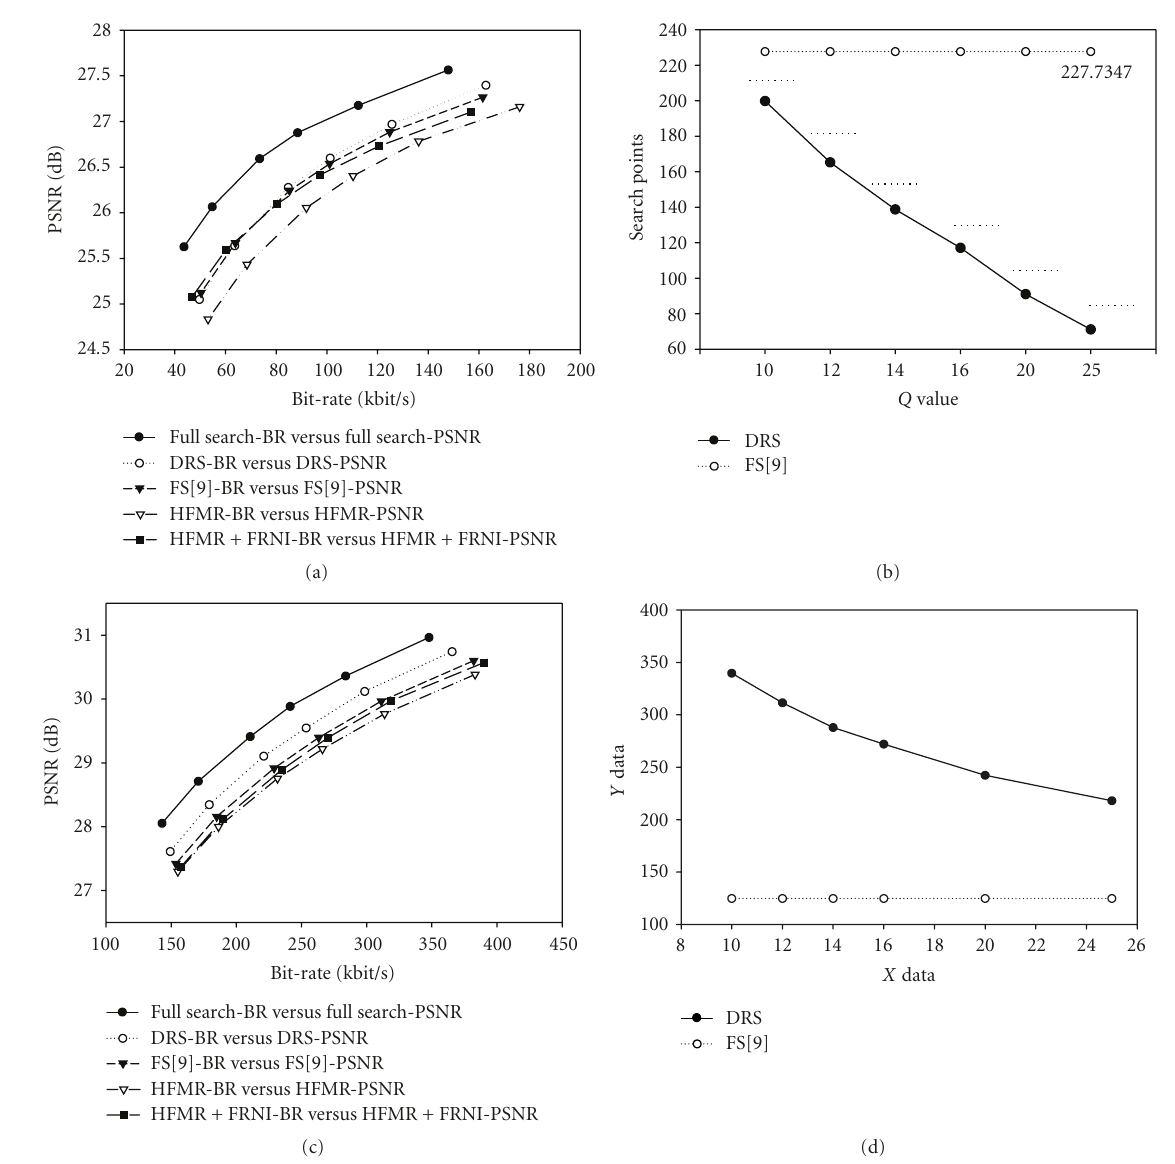
Figure 19: Simulation results for DRS. (a) The R-D curves of Coastguard. (b) Average search points per frame for Coastguard. (c) The R-D curves of Football. (d) Average search points per frame for